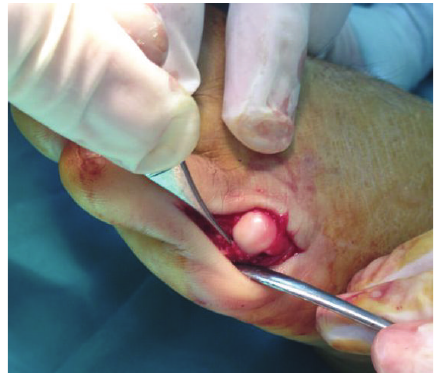
Figure 2: Extracting of entrapped plantar plate from MTP joint.